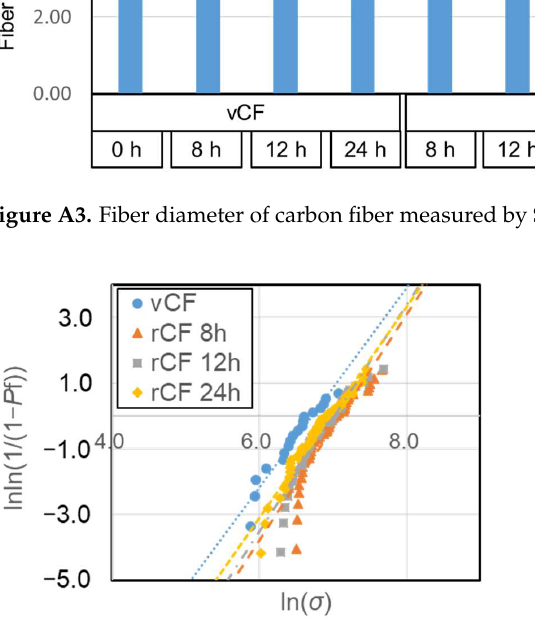
Figure A4. Weibull distribution plots for vCF and rCF of representative data.